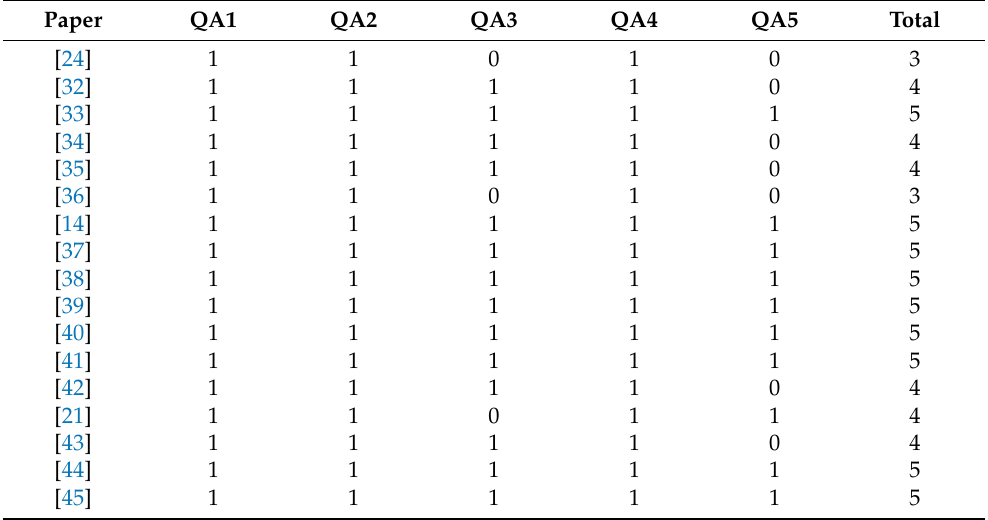
Table 2 presents our findings regarding specific phobia using augmented and virtual reality, and Table 3 provides existing paper types. Table 2. Existing papers on specific phobia exposure therapy using virtual and augmented